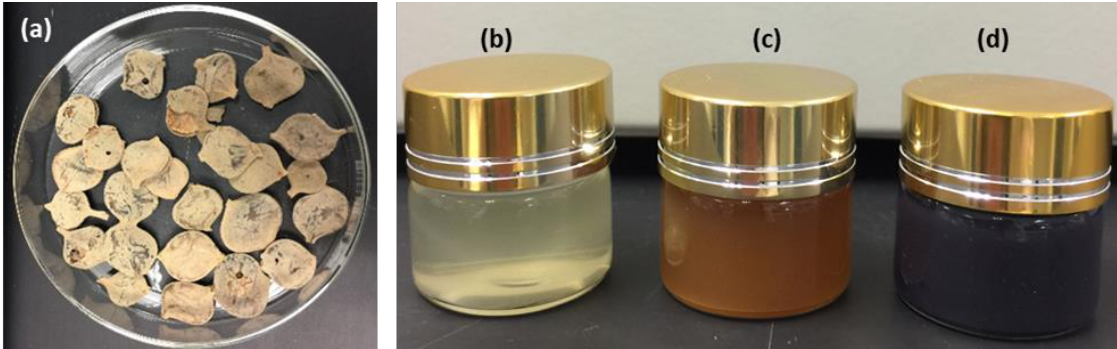
Figure 1. Seedless pods of Acacia nilotic a ( a ); FeSO 4 solution ( b ); Acacia nilotica extract (ANE) ( c ); and the mixture of both ( d